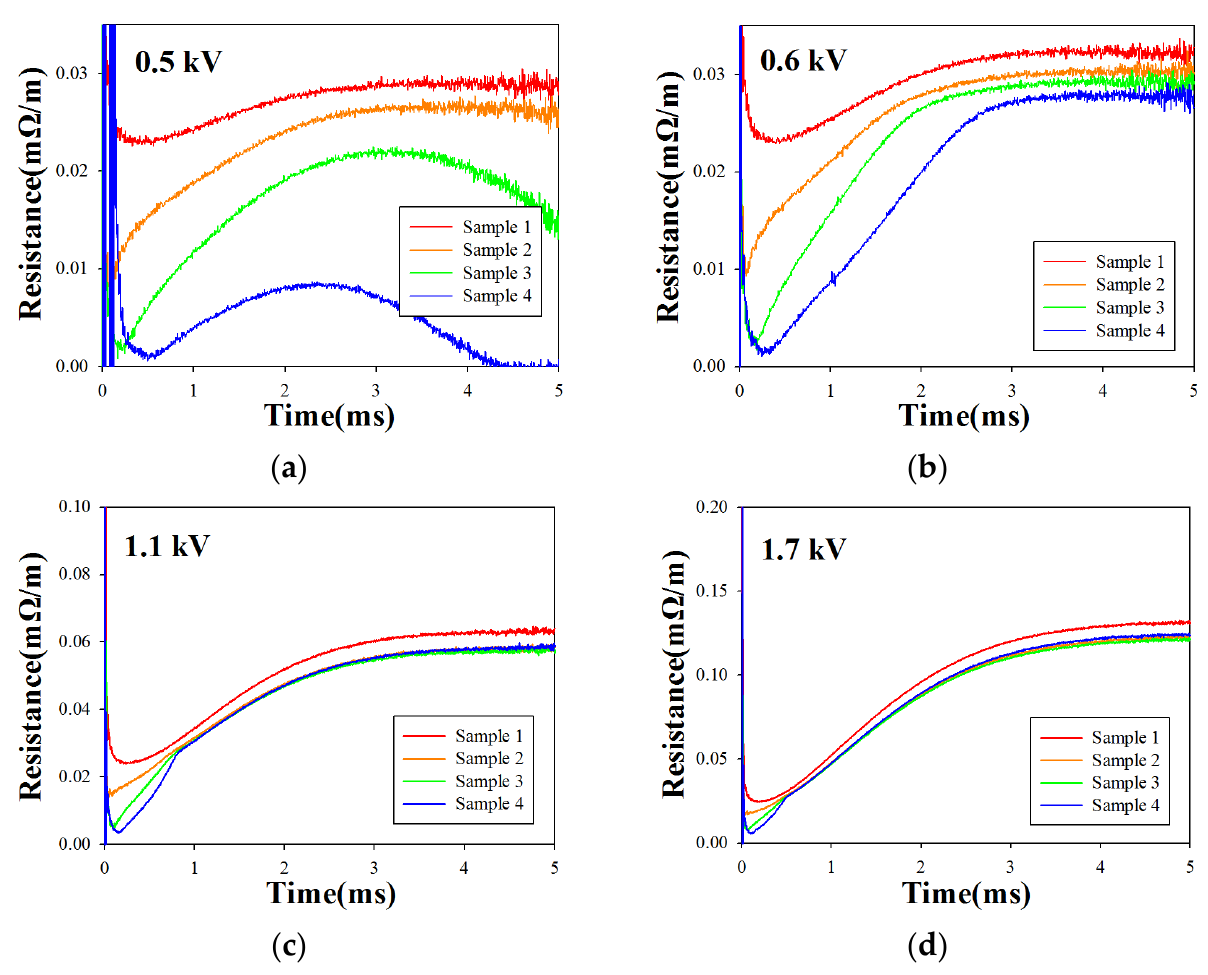
Figure 15. Impulse resistance response of samples 1–4: ( a ) 0.5 kV impact; ( b ) 0.6 kV impact; ( c ) 1.1 kV impact; ( d ) 1.7 kV impact.